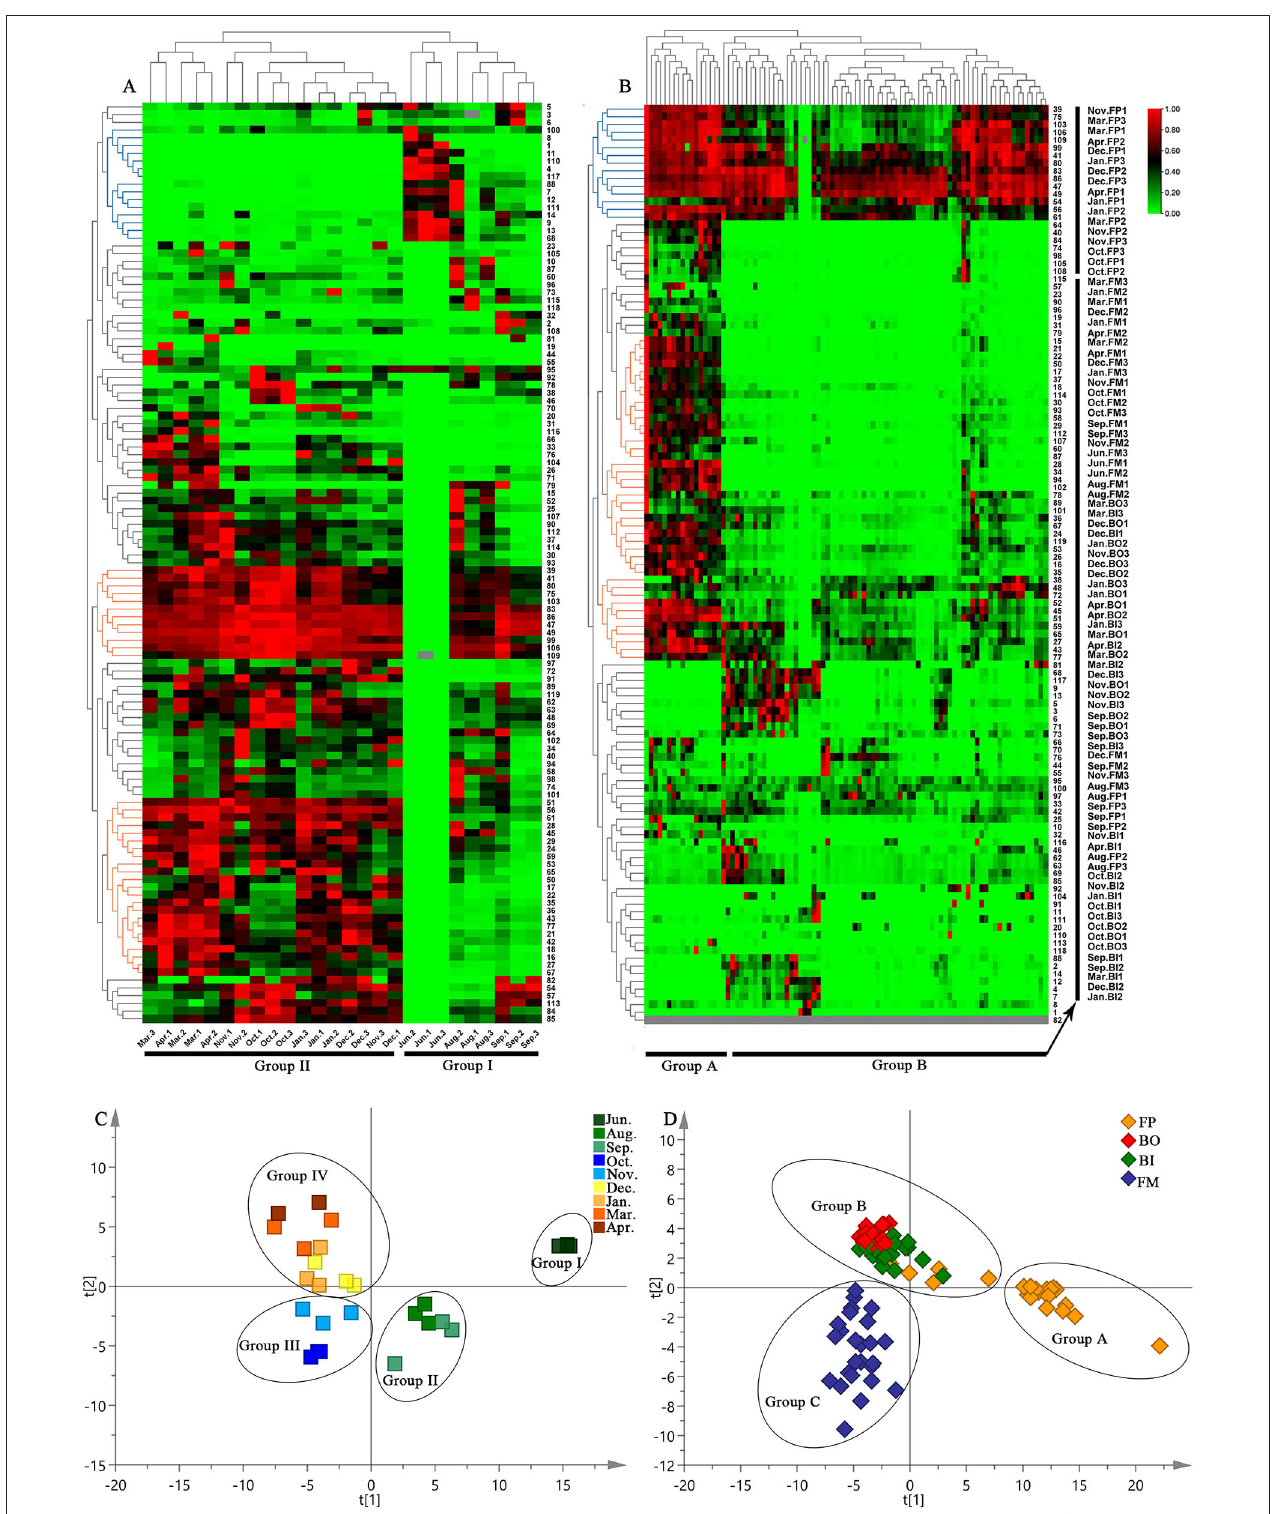
FIGURE 4 | Hierarchical clustering analysis heat maps for the nine growth periods (A) and four parts (B) of the Fushen, PLS-DA score plots of nine growth periods (C) and four parts (D) of the Fushen based on UPLC-Q/TOF-MS in ESI − .